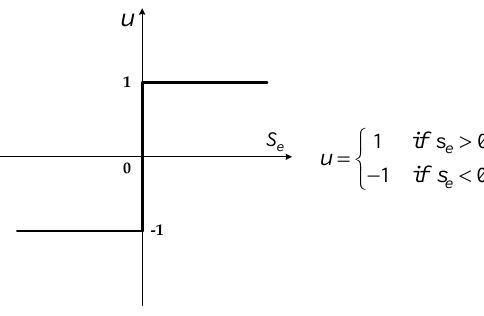
Figure 9. Method for driving the traditional solenoid valve switch.